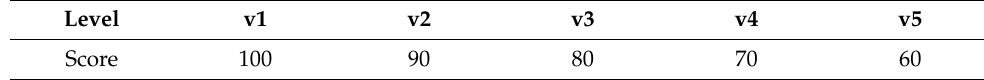
Table 4. Results of index membership.